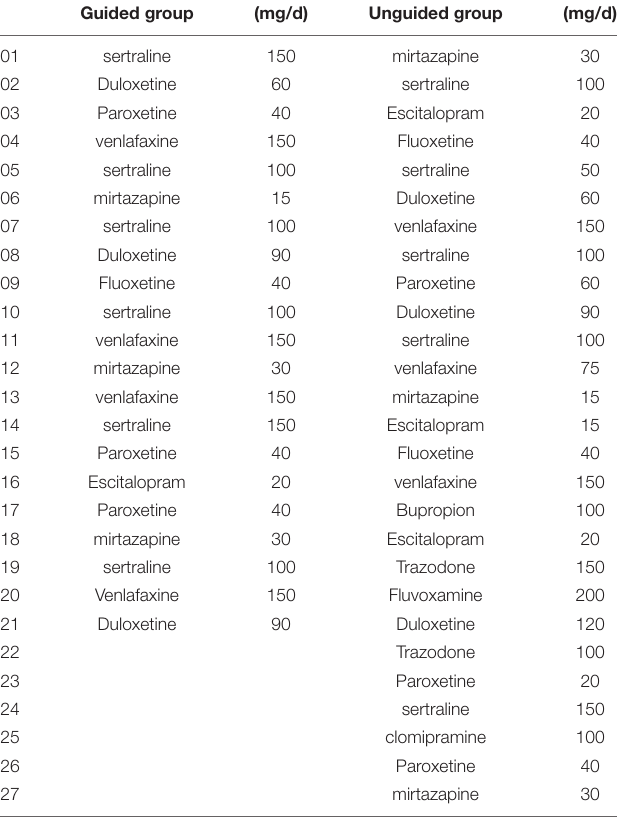
TABLE 2 | The usage and dosage of antidepressants in patients of guided and unguided groups.